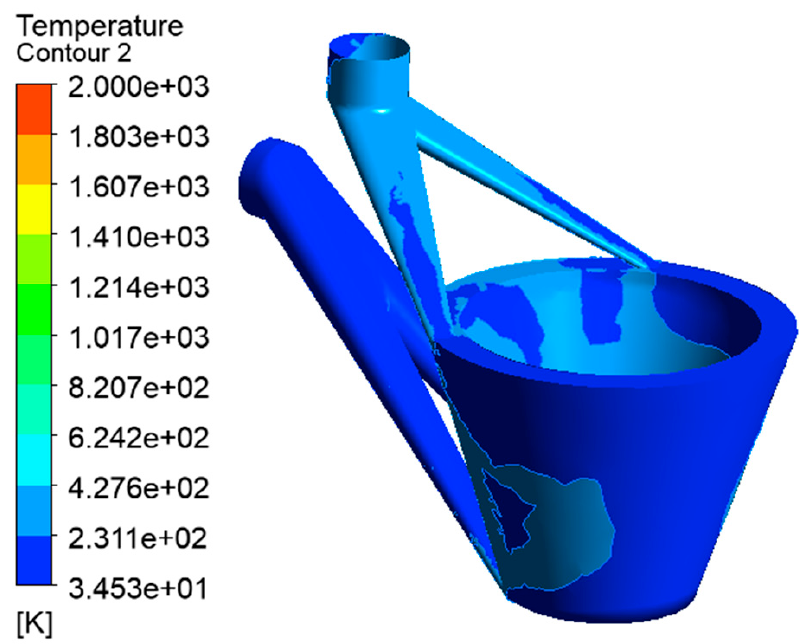
Figure 4. Temperature distribution of cooling water.